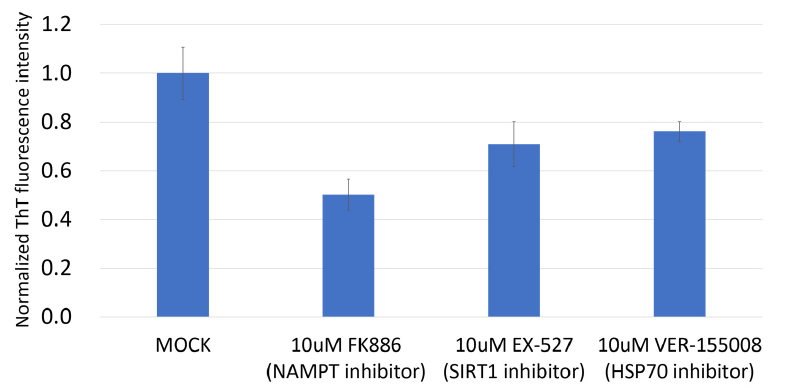
Figure 6. NAMPT has a higher level of expression in Detroit 562 cells than in OECM-1 cells. Although the levels of NAMPT, SIRT1, and HSP70 expression in Detroit 562 were larger than in OECM-1, the NAMPT expression showed, by far, the greatest difference between the two cell lines. Gene expression in OECM1 cells was calculated as 1.